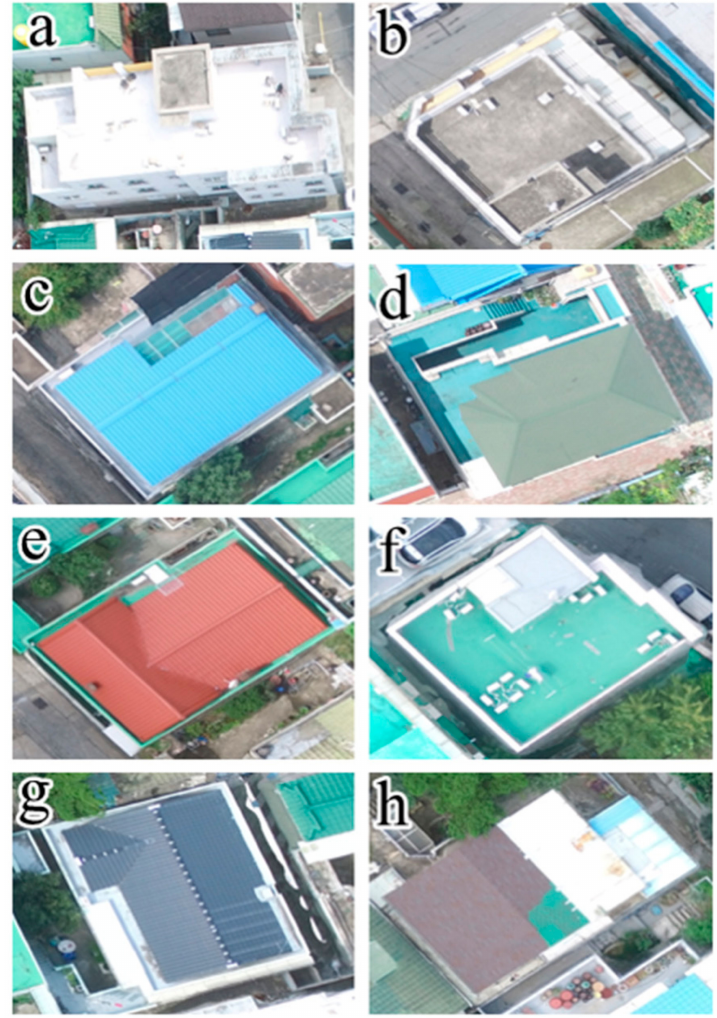
Figure 4. Visible UAV Imagery of sample rooftops: ( a ) white, ( b ) gray, ( c ) blue, ( d ) cyan, ( e ) red, ( f ) green, ( g ) black, and ( h )